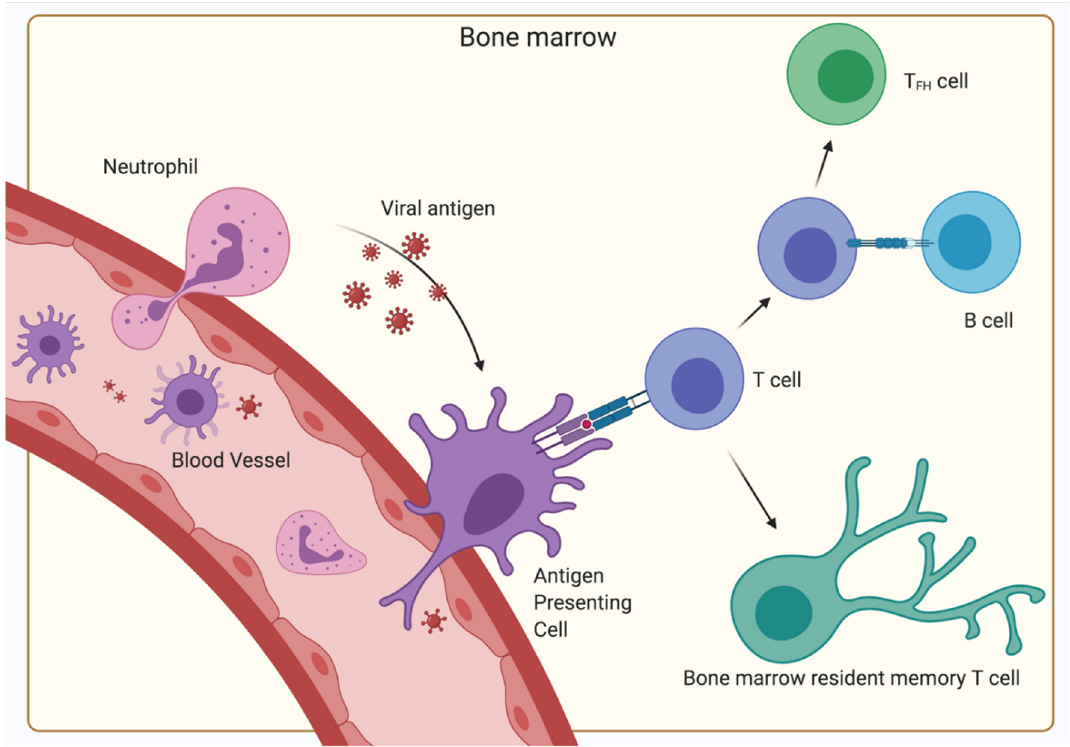
Figure 3. Primary immune response in the BM. Antigen is transported via the blood vessels, antigen-presenting cells (typically dendritic cells) or neutrophils to the BM. There, the antigen-presenting cells display the antigen on their MHC receptors and interact with naïve T-cells inducing their differentiation into BM resident memory T-cells. Some CD4 + T-cells are stimulated to differentiate into T FH by bystander B-cells after the initial antigen-MHC II—TCR interaction. (Created with